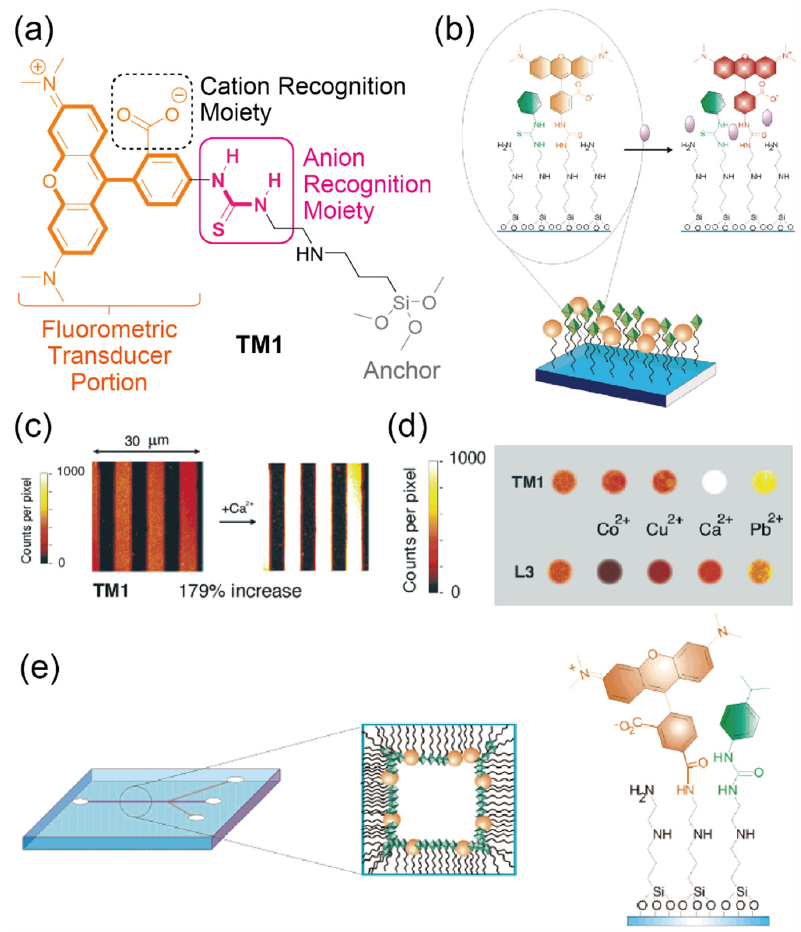
Figure 8. ( a ) Chemical structure of the TAMRA-attached SAM ( TM1 ) for fluorometric